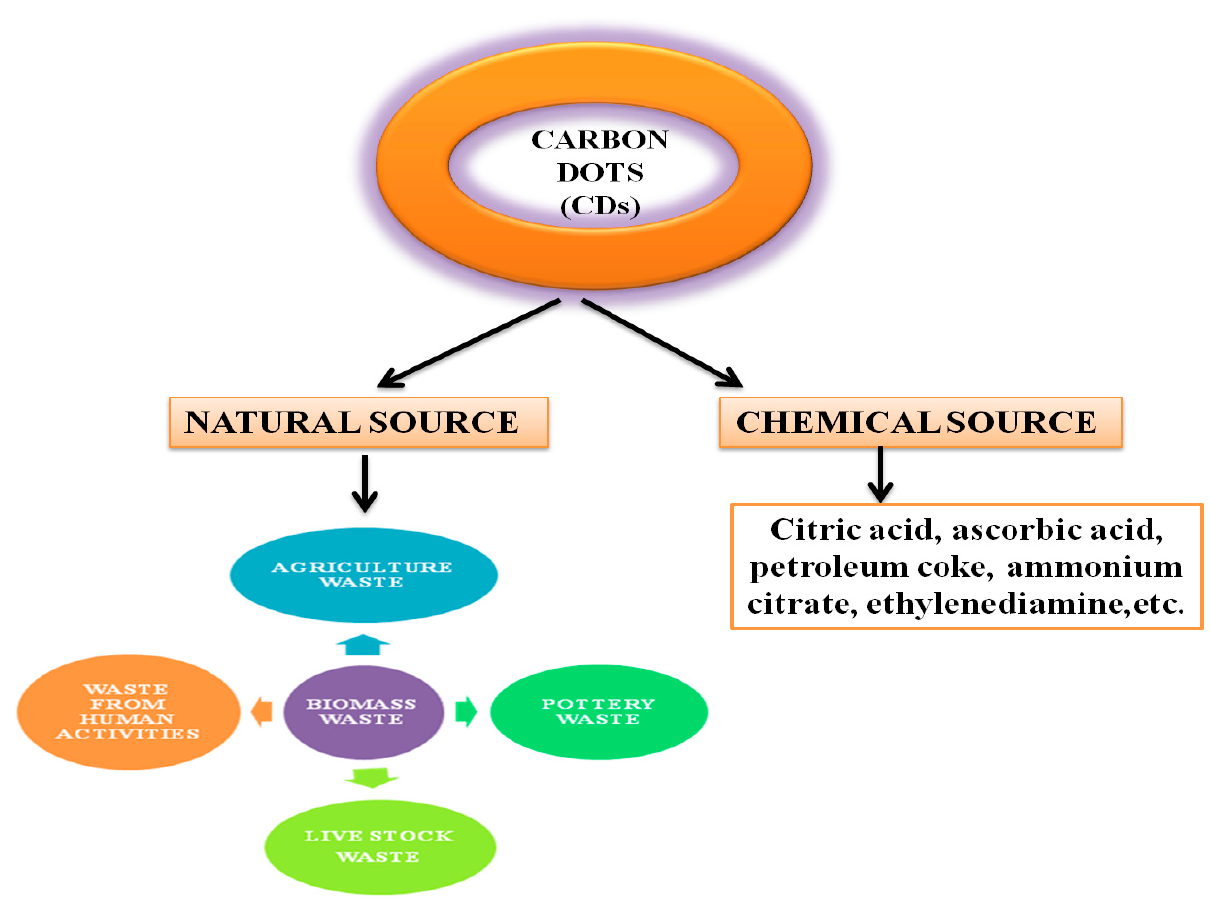
Figure 2. Natural and chemical sources of precursors used in the synthesis of CDs.